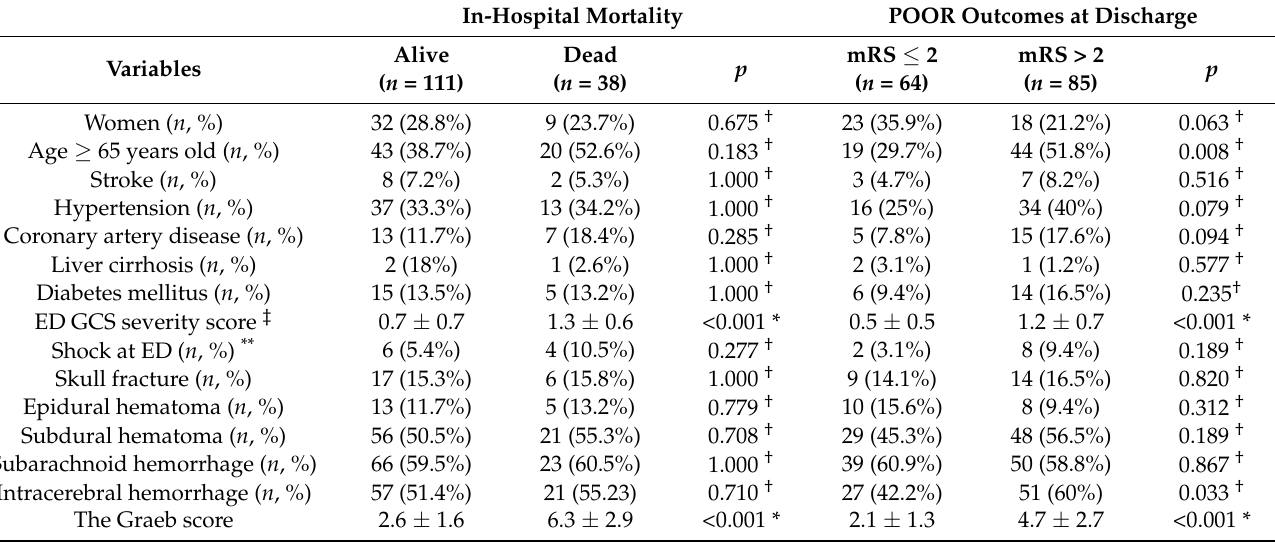
Table 3. Univariate analysis for predictors of in-hospital mortality and poor outcomes at discharge in patients with tIVH.